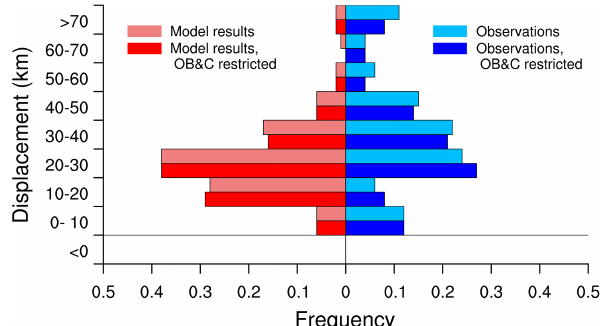
Figure 6. Histograms for the distribution of daily maximum dis- placement distances (cid:49)d (cid:49)t max , defined by Eq. (5). Horizontal bars pointing left and right correspond to results from SVIM model sim- ulation and ice chart data, respectively. Light colored bars display results from the original algorithm in Sect. 2.1, while bars with reg- ular colors (labeled “OB&C restricted”) result after the extension in Appendix B for open boundaries and coastlines is applied. Results from 354d of 24h edge displacements have been analyzed, see the text for further